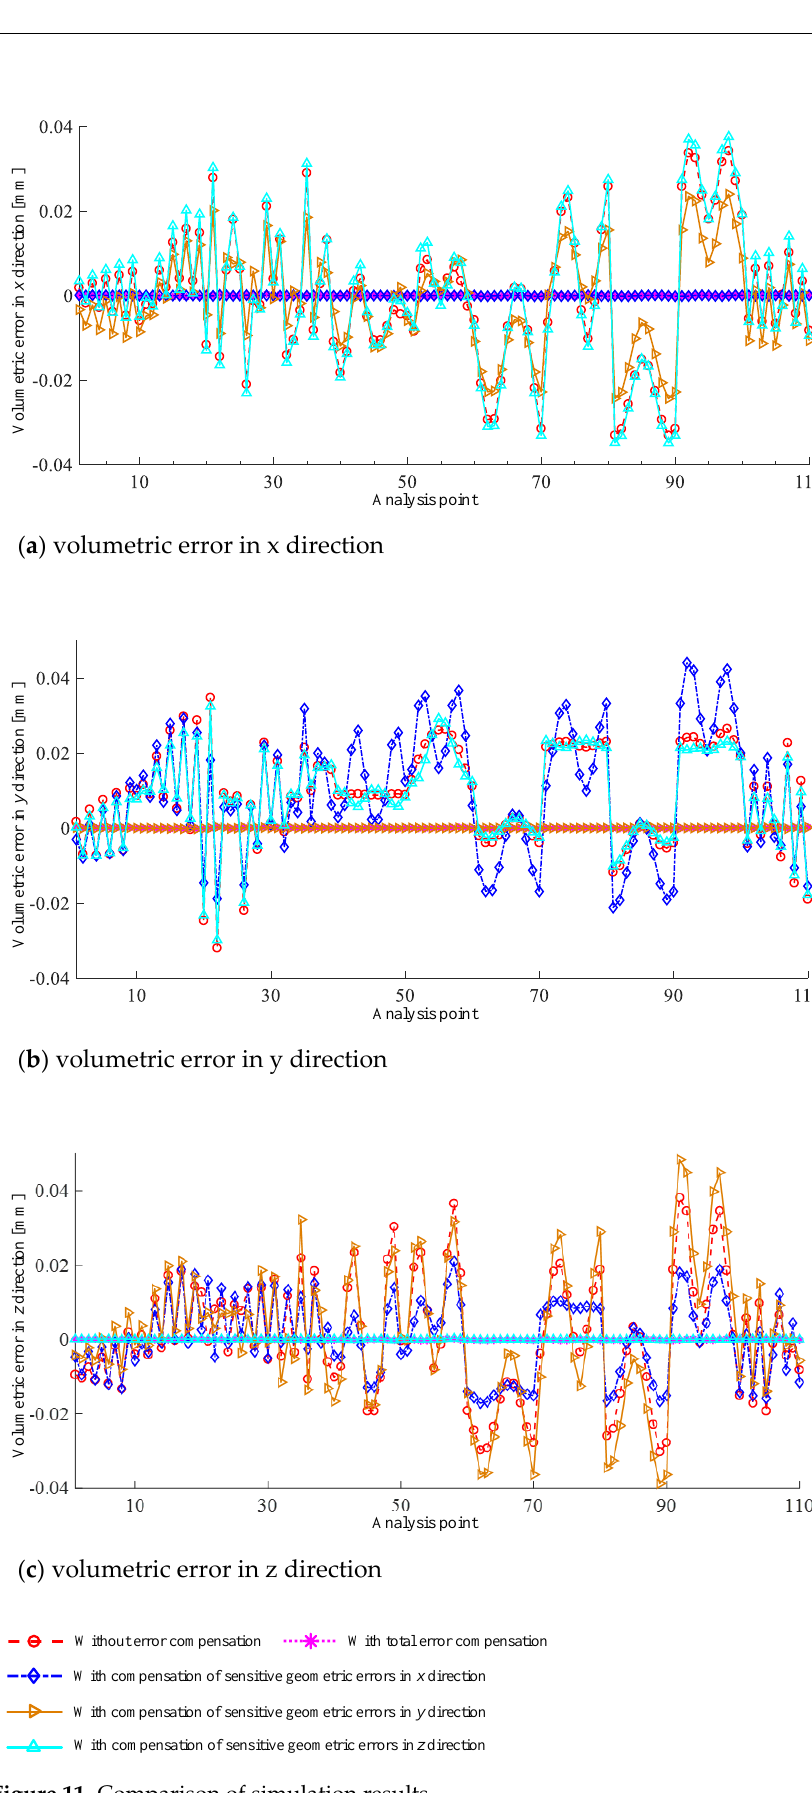
Figure 11. Comparison of simulation results.